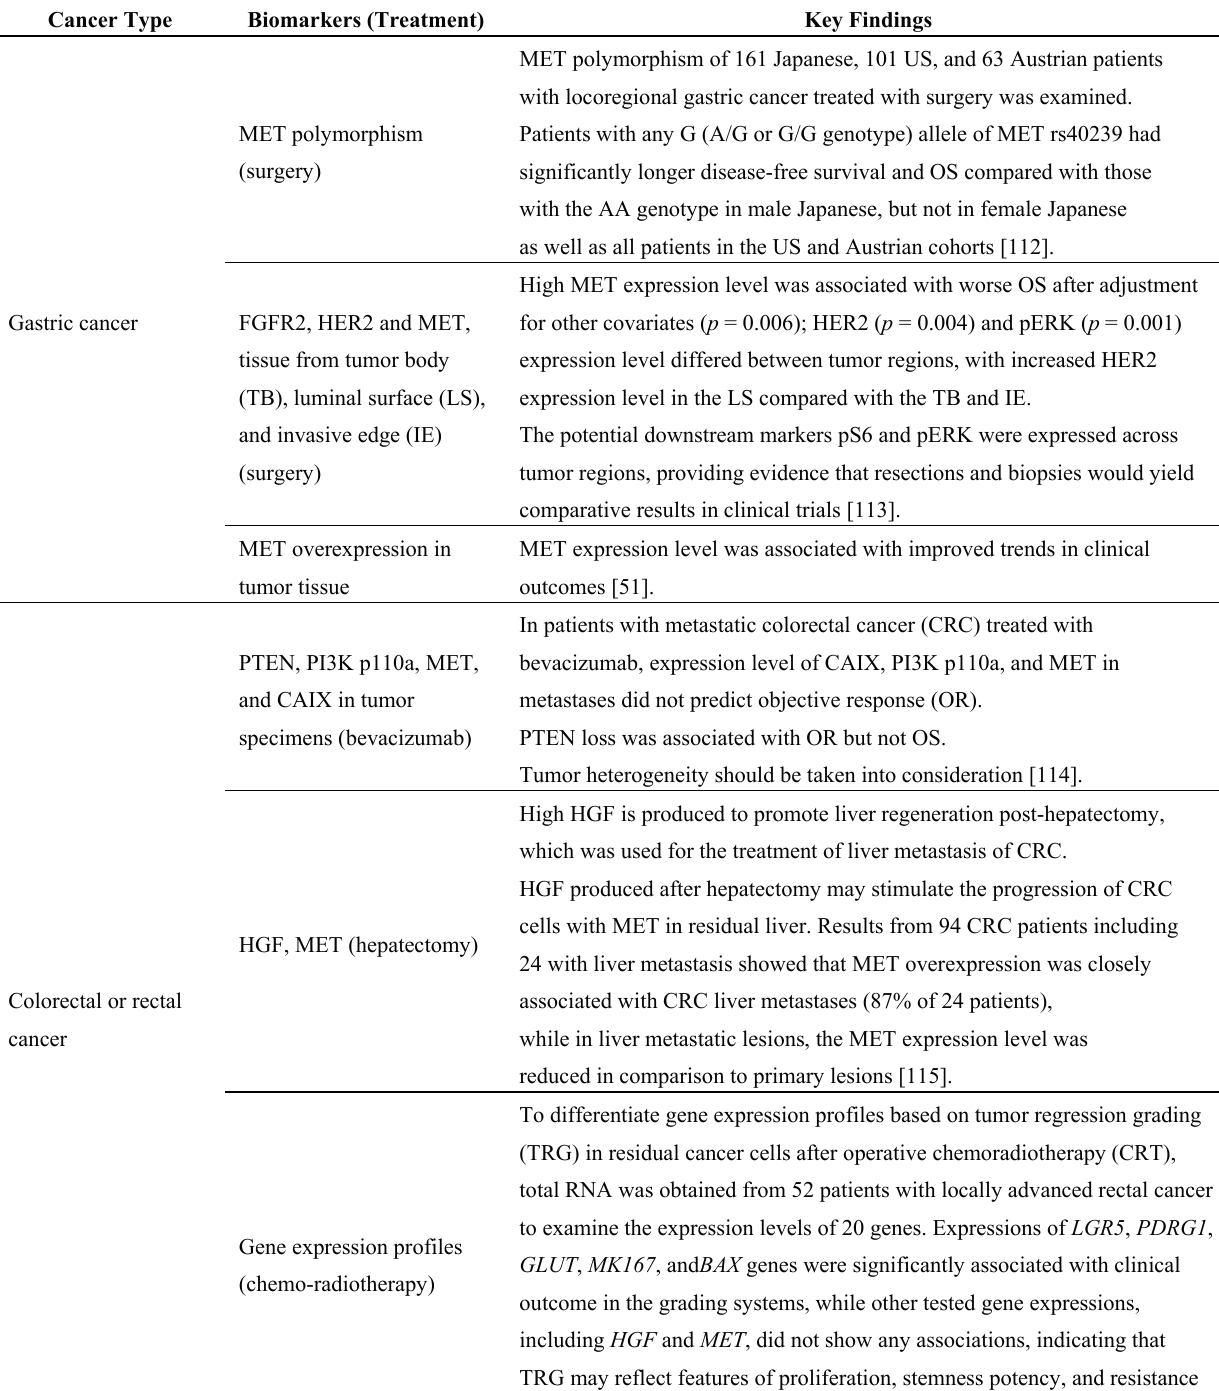
Table 3. Examples of MET biomarkers in different